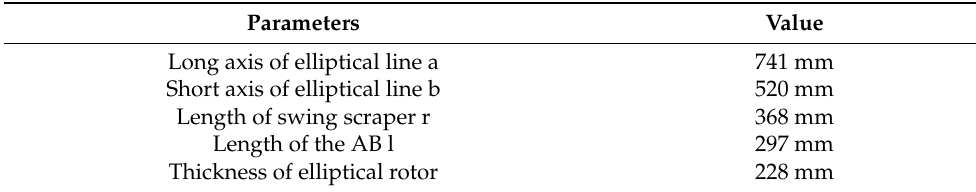
Table 1. Basic parameters of the ERSP. Parameters Value Long axis of elliptical line a 741 mm Short axis of elliptical line b 520 mm Length of swing scraper r 368 mm Length of the AB l 297 mm Thickness of elliptical rotor 228 mm